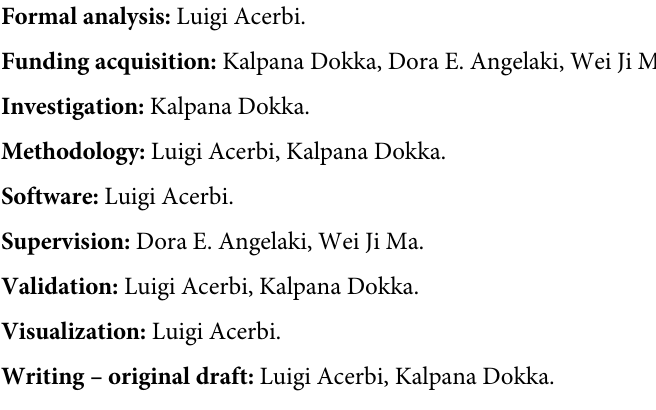
S1 Fig. Explicit causal inference; model fits of full data. Results of the explicit causal infer- ence (unity judgment) task, for two models of interest. Proportion of ‘unity’ responses for a given ( s , s ) heading direction pair (indexed from 1 to 99), and for different levels of visual vis vest cue reliability. Points are data, lines are model fits (average fit across subjects). Error bars are omitted for clarity. A : Best Bayesian model (Bay-X-E). B : Best fixed-criterion model (Fix-C). Neither model appears clearly superior across all noise levels (see main